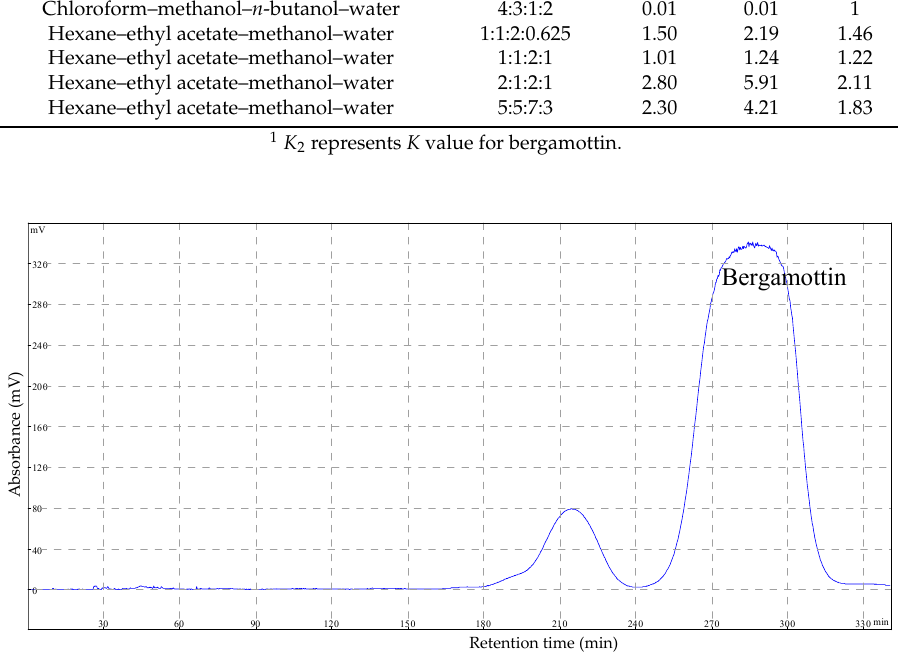
Figure 2. High-speed counter-current chromatography (HSCCC) chromatogram of the purification of bergamottin extracted from the silica gel-refined sample. Two-phase solvent system: hexane–ethyl acetate–methanol–water (1:1:2:0.625, v / v / v / v ); stationary phase: upper phase; mobile phase: lower phase; flow rate: 2.0 mL·min − 1 ; revolution speed: 900 rpm; detection wavelength: 250 nm.